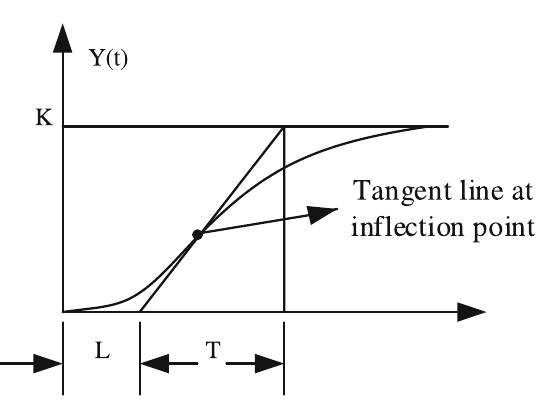
Fig. 15 Response curve of Cohen-Coon tuning formula